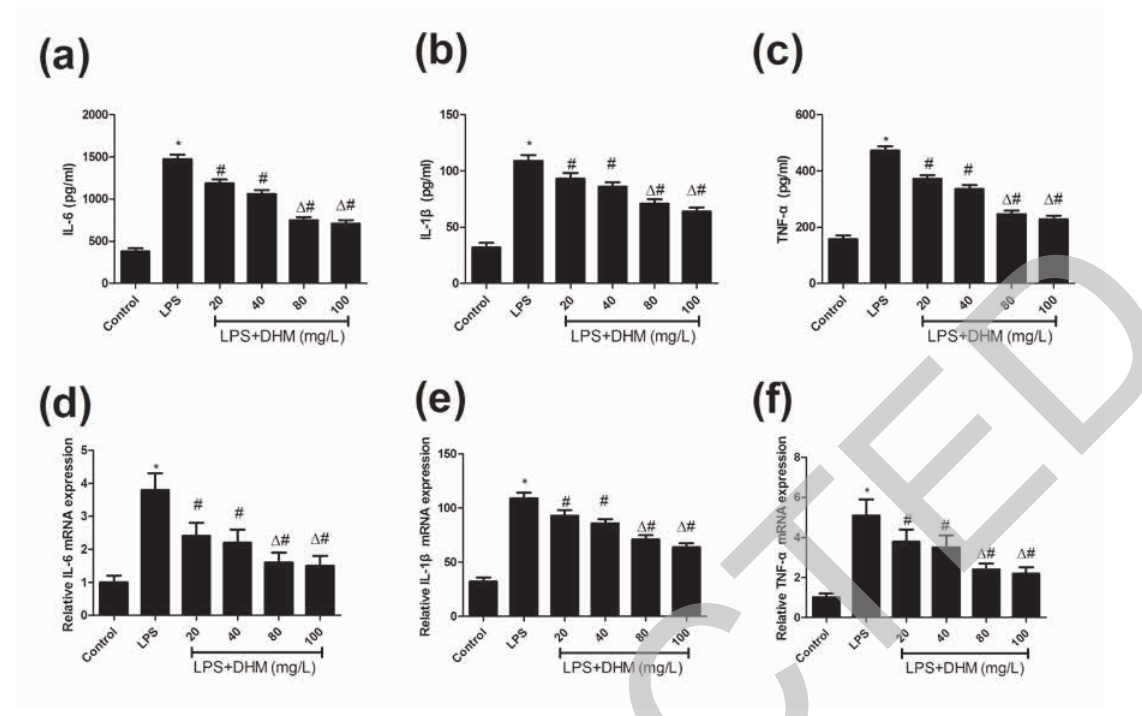
Figure 2: The effects of various concentrations of DHM (20, 40, 80 or 100mg/L) on inflammatory response. (a-c) DHM (20, 40, 80 or 100mg/L) significantly suppressed the LPS-induced upregulation of pro-inflammatory cytokines IL-6, IL‐1β and TNF-α in BV-2 microglial cells. (d-f) DHM (20, 40, 80 or 100mg/L) significantly suppressed the LPS-induced increased mRNA levels of IL-6, IL‐1β and TNF-α in BV-2 microg- lial cells. *P<0.01 compared with control group; # P<0.01 compared with LPS group; Δ P<0.01 compared with DHM 20 or 40 mg/L